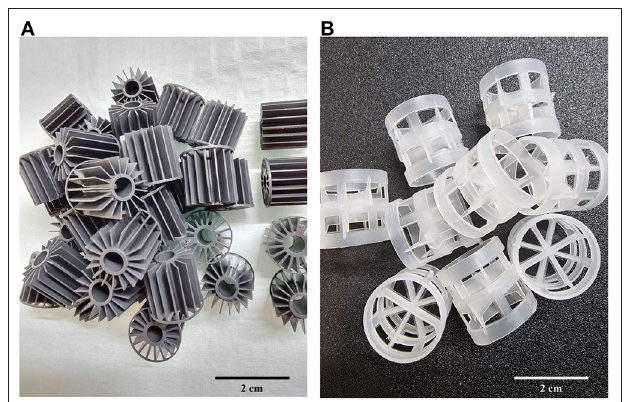
FIGURE 4 | Bio-media picture. Moving bed bioreactor media (A) and degasser media (B)